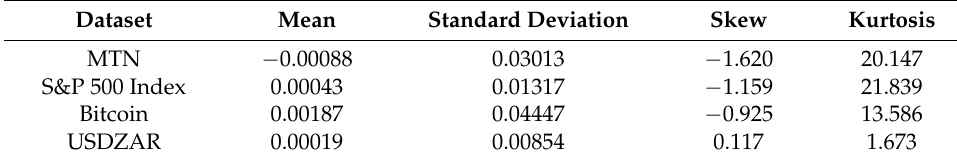
Table 2. Descriptive statistics for the jump diffusion process datasets. Dataset